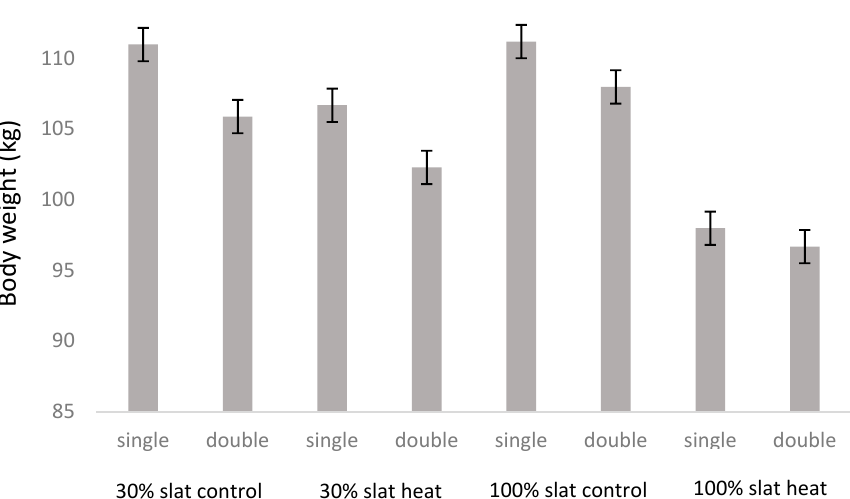
Figure 5. Mean ± SE of pig body weight at the end of the study depending of the environmental temperature (control vs. heat), type of floor (30% slat 70% concrete vs. 100% slat), and number of feeders per pen (one: single; two: double).